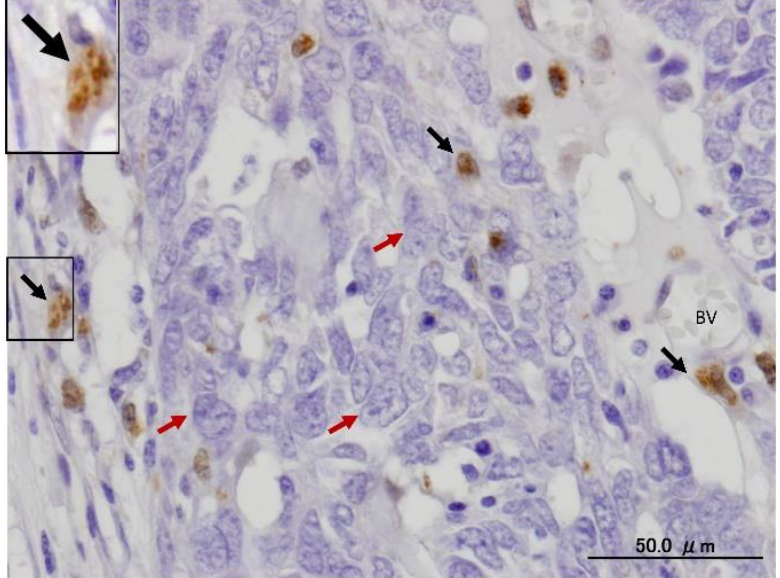
Figure 3. Expression of LC3 in stromal cells of serious human ovarian carcinoma using IHC . The black arrows indicate LC3-II puncta in stromal cells, whereas the red arrows mark ovarian cancer cells. The framed area is magnified in the inset. BV, blood vessel. The avidin biotin complex (ABC) IHC method is performed. The diaminobenzidine (DAB) is used as a chromogen (brown reaction), whereas the hematoxylin (blue) is applied for nuclear counterstaining.